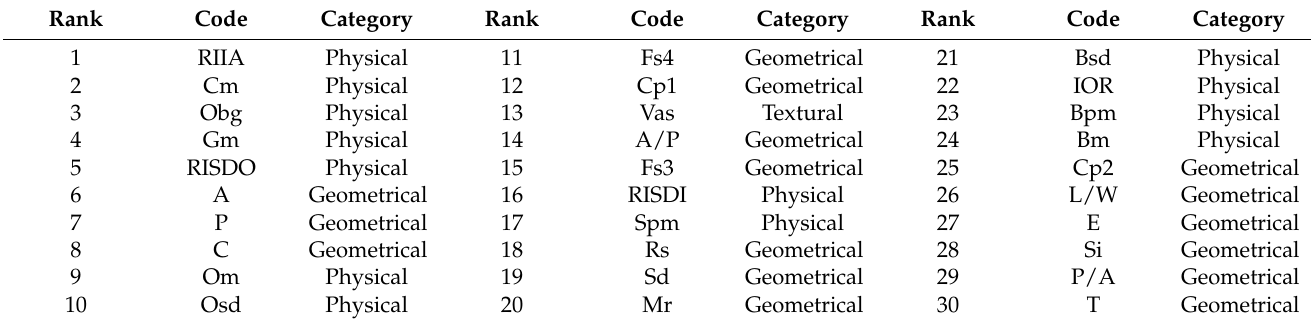
Table 2. A subset of features obtained for dark spot segmentation using the SVM-RFE algorithm.